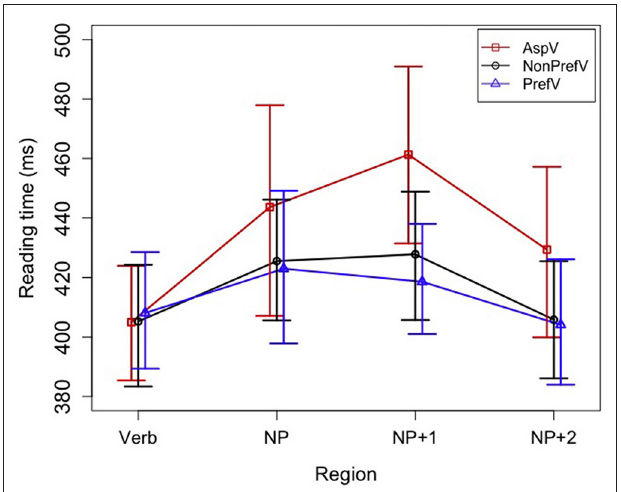
FIGURE 1 | Mean reading times by verb type and region. The error bars indicate the difference-adjusted 95% (percentile) mixed-effect-model-based intervals ( Politzer-Ahles, 2017). The intervals can be generally interpreted as indicating that when one sentence type’s interval does not include another sentence type’s mean, the two types are likely (but not guaranteed) to be significantly different in a mixed effect model.